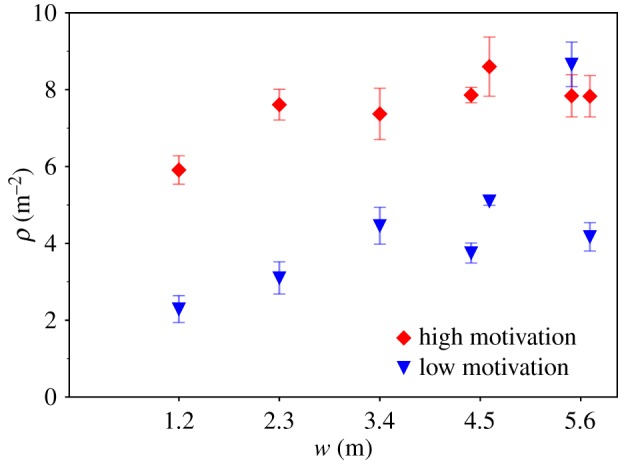
Mean density ρ within time interval t = 5 s to t = 10 s and within the measurement area versus corridor width w for all runs with N < 40.